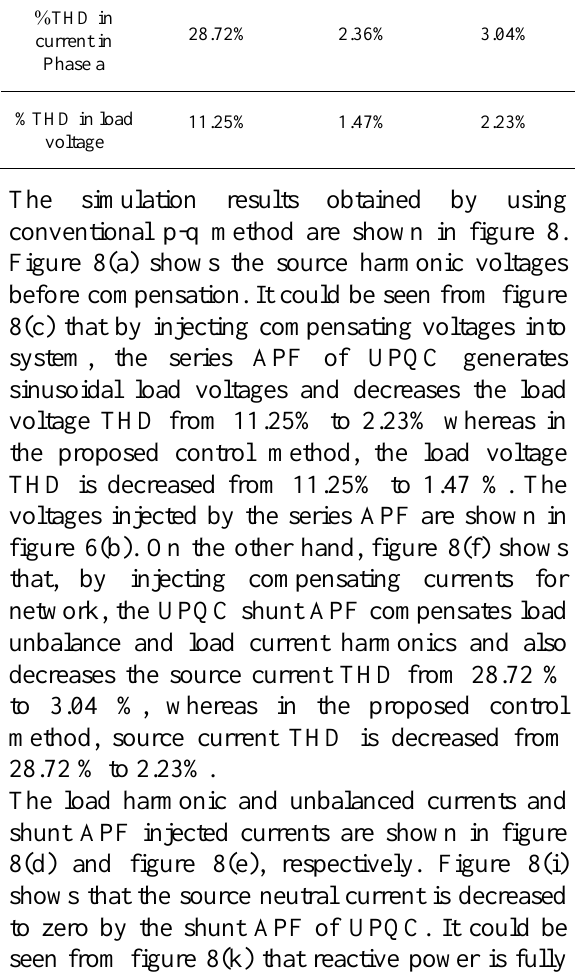
Table 2. % THD of the supply currents and load voltages . Supply currents/load